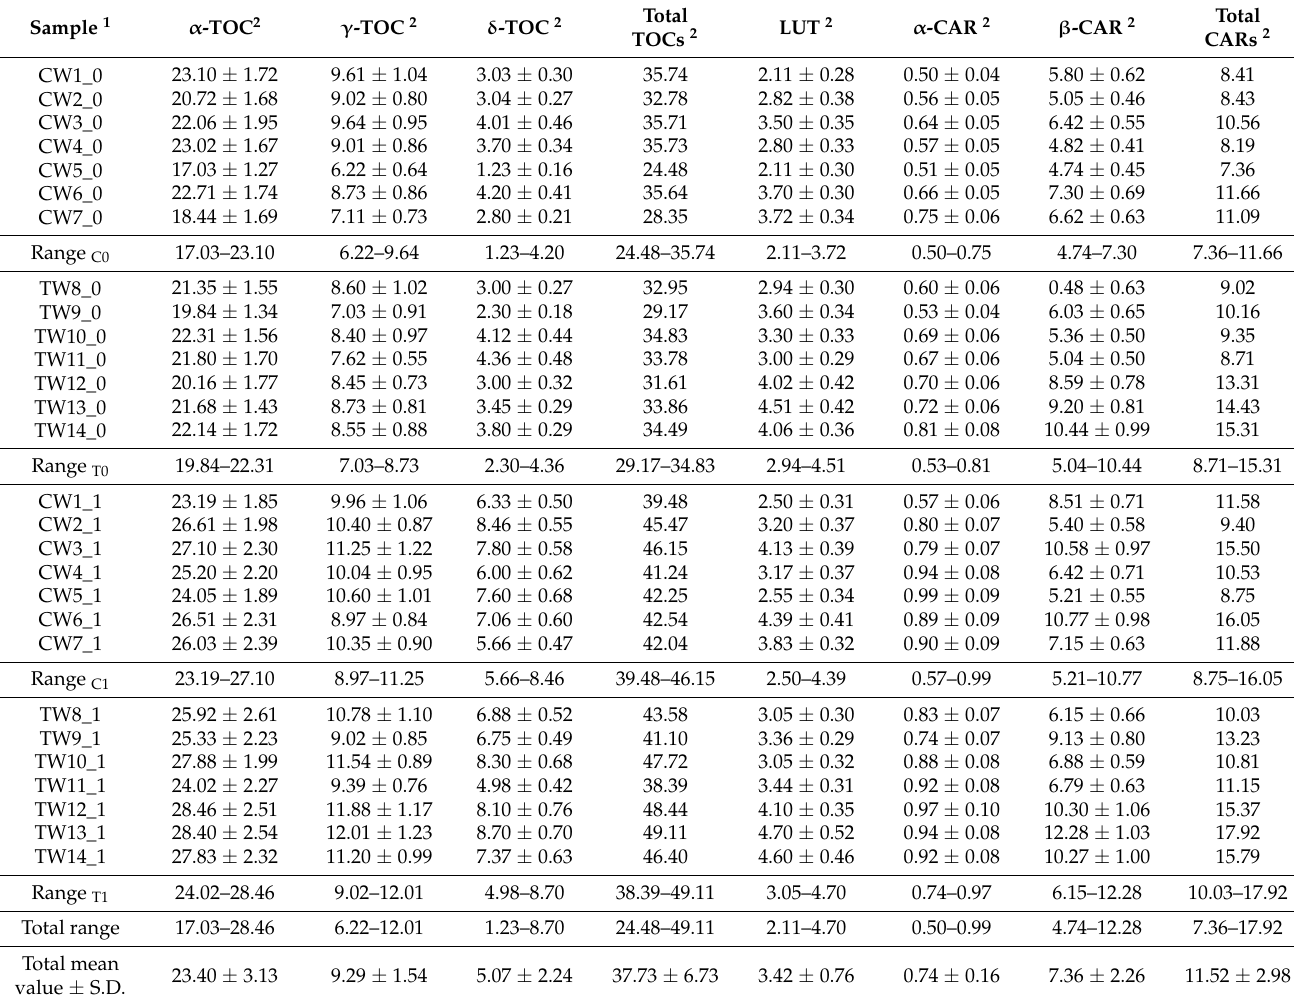
Table 1. Occurrence of tocopherols ( α -, δ -, and γ -tocopherol) and carotenoids ( α -carotene, β -carotene, and lutein) in “Ragusano” cheese samples produced in the winter. Concentrations (mg/kg fresh weight) of single compounds are expressed as mean ± s.d. (n = 3